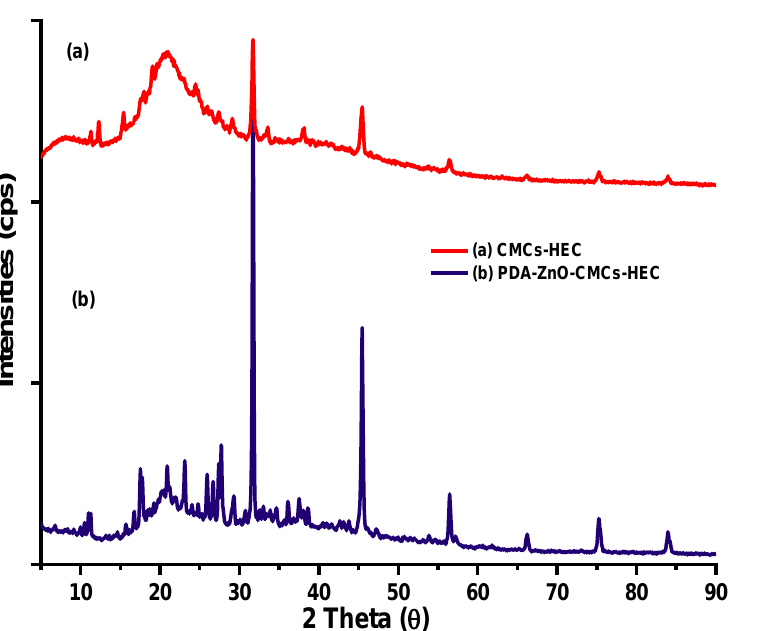
Figure 5. X-ray diffractograms of (a) CMCs-HEC and (b) PDA-ZnO-CMCs-HEC hydrogels.